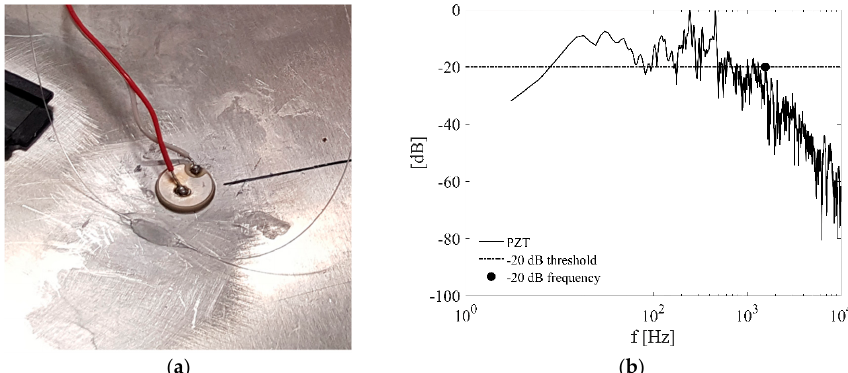
Figure 5. ( a ) Detail of the sensing optical fiber glued to the aluminium plate for passive impact monitoring; ( b ) Power spectral density of the impact response of the PZT sensor located in the vicinity of the FOC